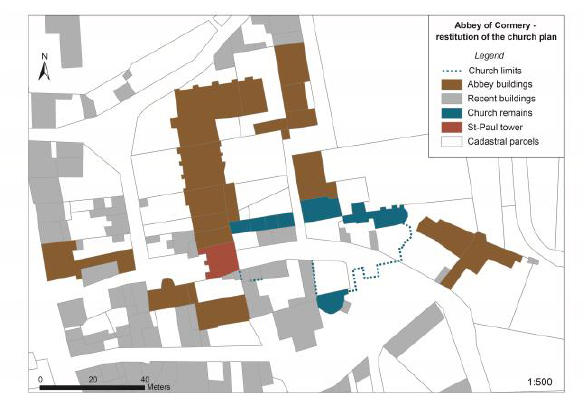
Figure 2. Map of the abbey of Cormery with the church